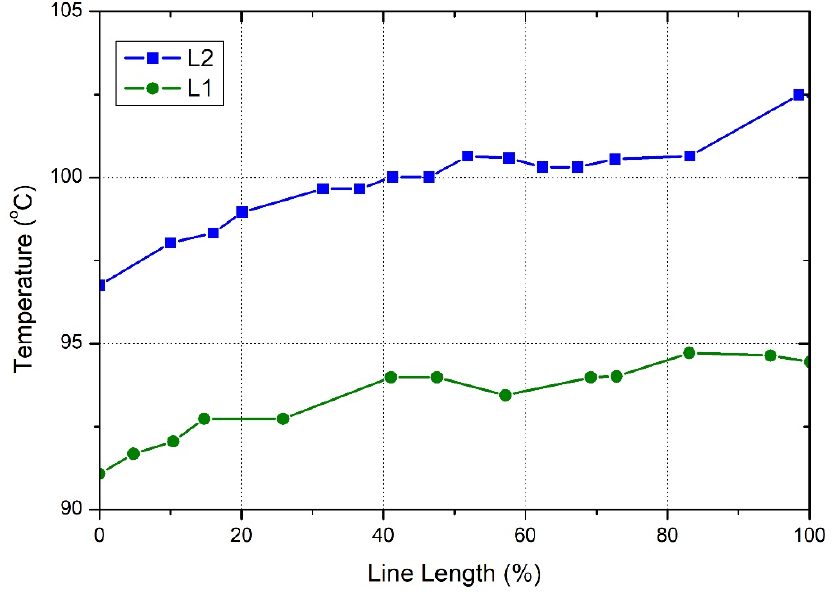
Figure 9. Bearings housing’s heat transfer distribution diagram.